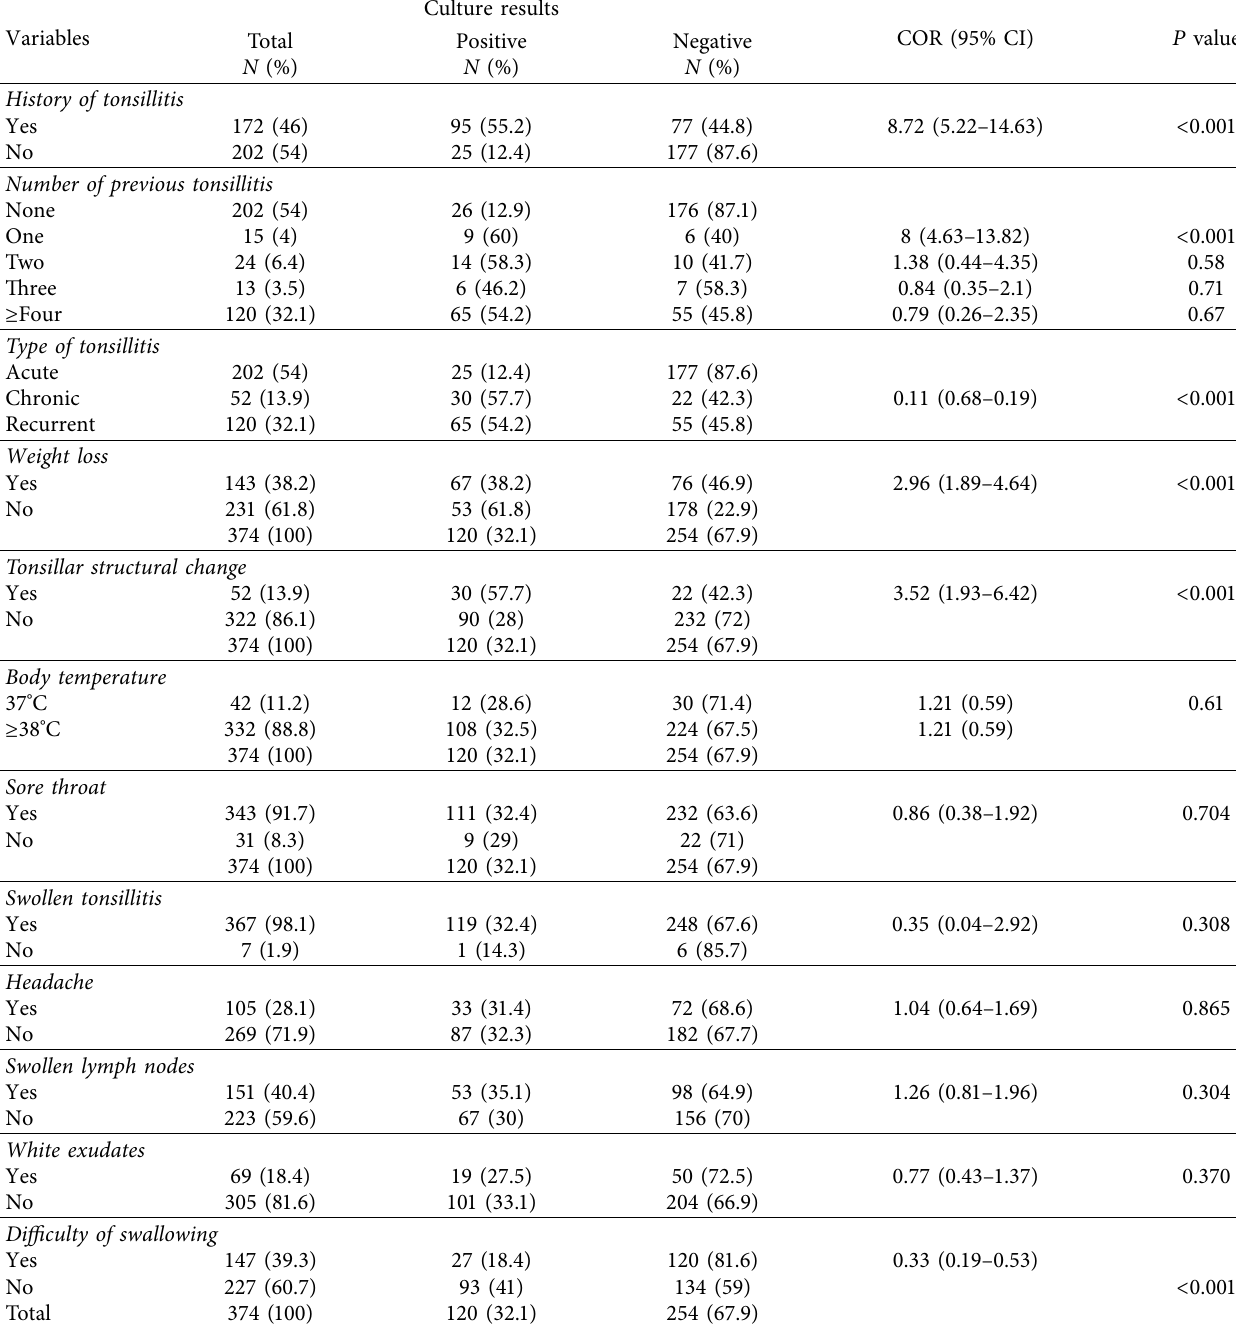
Table 2: Bacterial throat culture positivity and clinical profles of children with suspicion of bacterial tonsillitis at Hargeisa Group of Hospital.